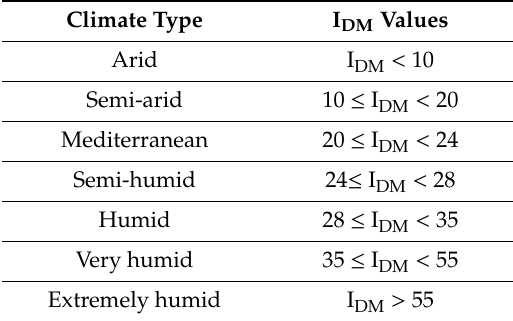
Table 2. Type of climate according to the de Martonne aridity index (I DM